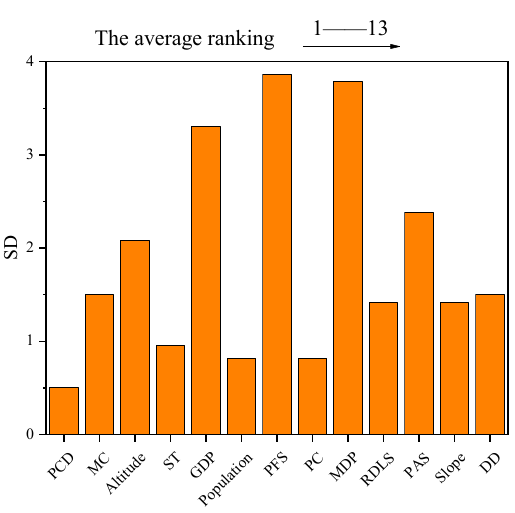
Figure 6. The standard deviations (SD) of PRD rankings of each conditioning factor.